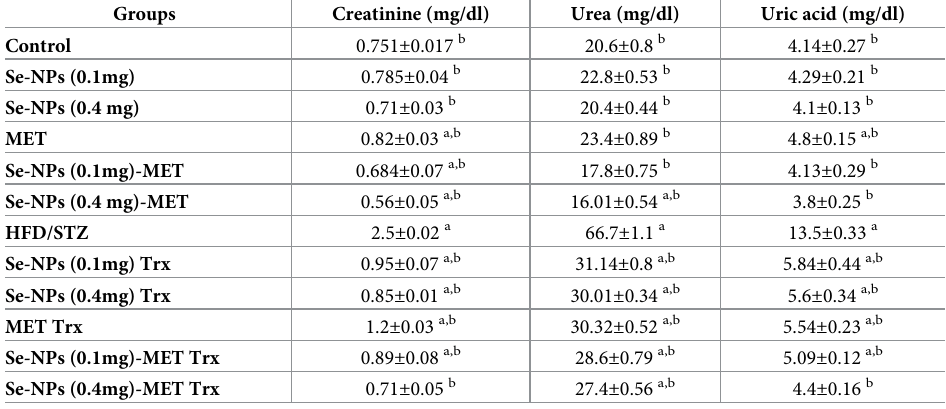
Values are mean ± SE (n = 10). Significant changes (p < 0.01) with respect to control and HFD/STZ-experimental rats are expressed by the letters (a) and (b), respectively.